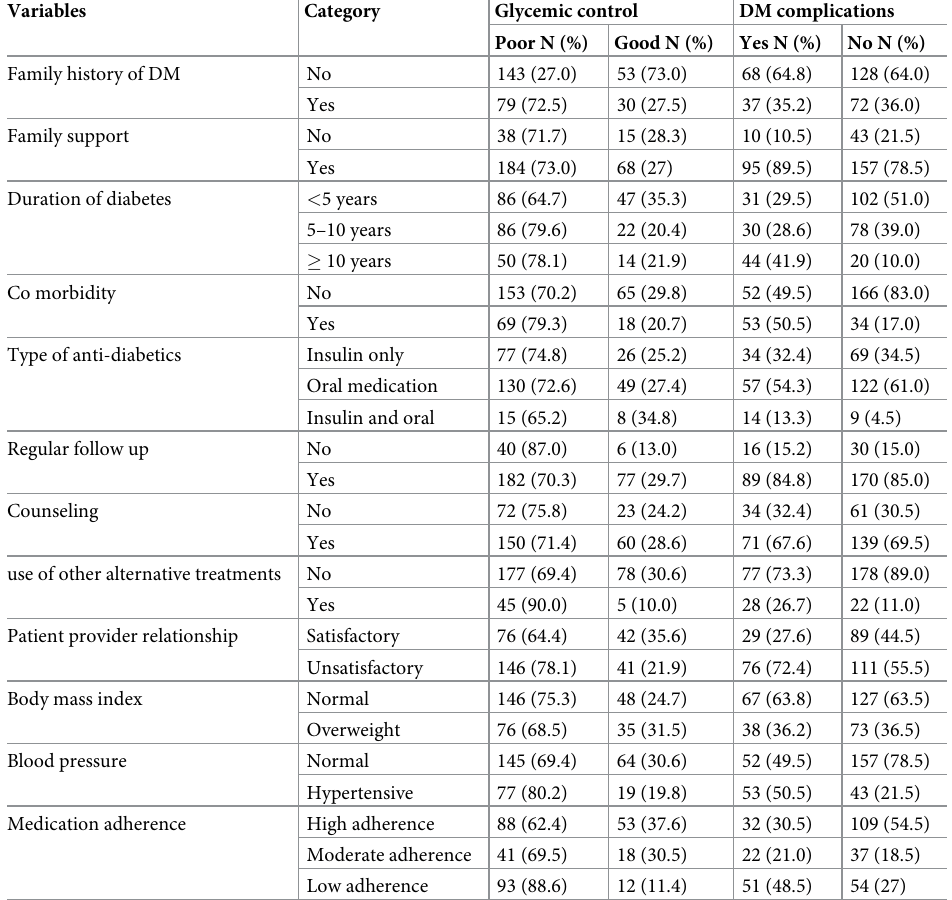
Table 2. Clinical and anthropometric characteristics of the study participants attending diabetic clinic at public hospitals in Hadiya zone, Southern Ethiopia, 2019.